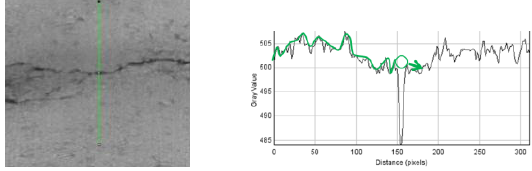
Figure 6. Pre-processing of Rolling Ball Background